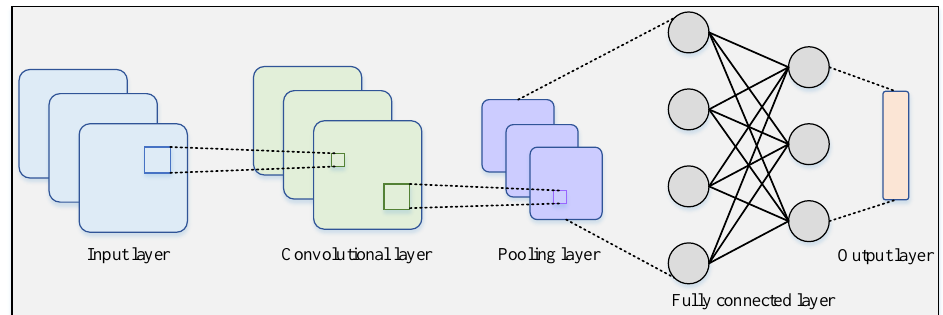
Figure 2. The structure diagram of a typical CNN.